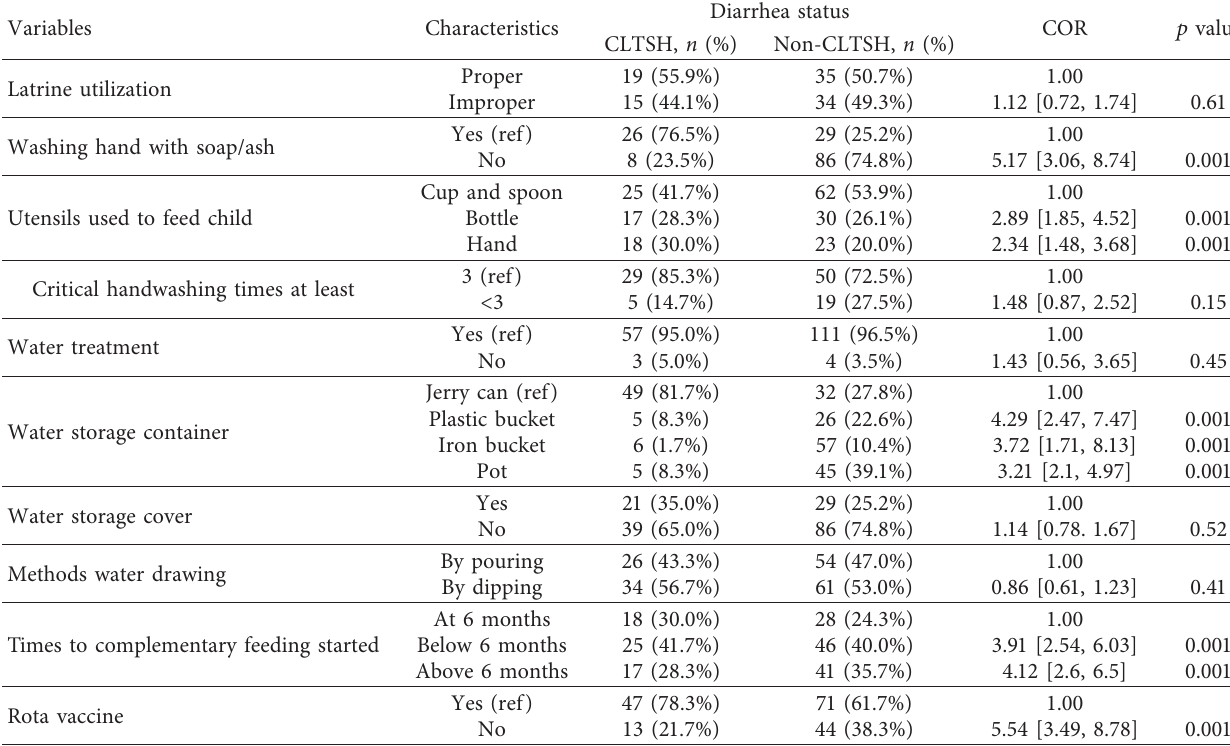
Table 7: Bivariate analysis of behavioral factors related to diarrhea among under-five in selected CLTSH implemented and nonimplemented woredas in Gamo Gofa Zone, March 2018.